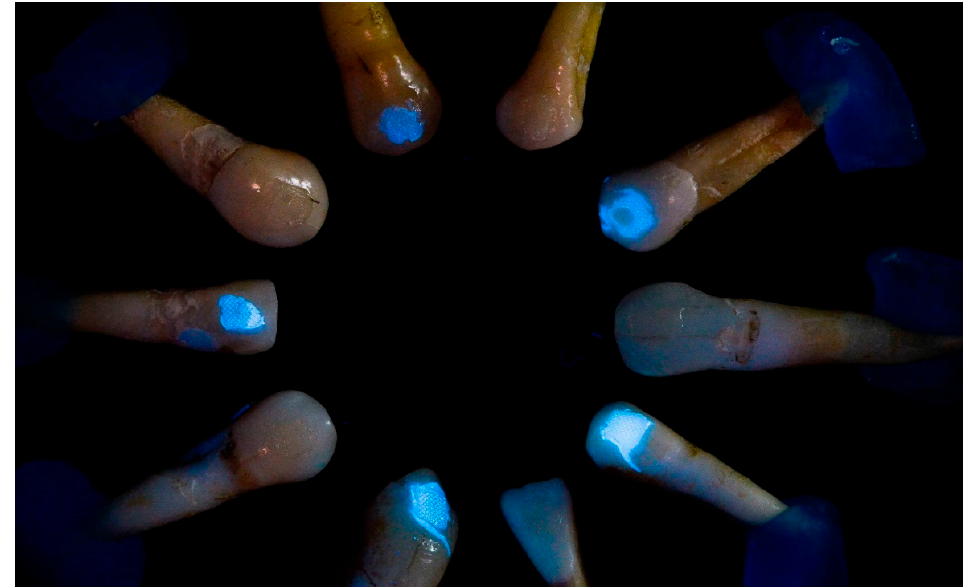
Figure 3. Visibility of Composite in two study groups under UV light (360–370 nm 20 mW/cm 2 ).